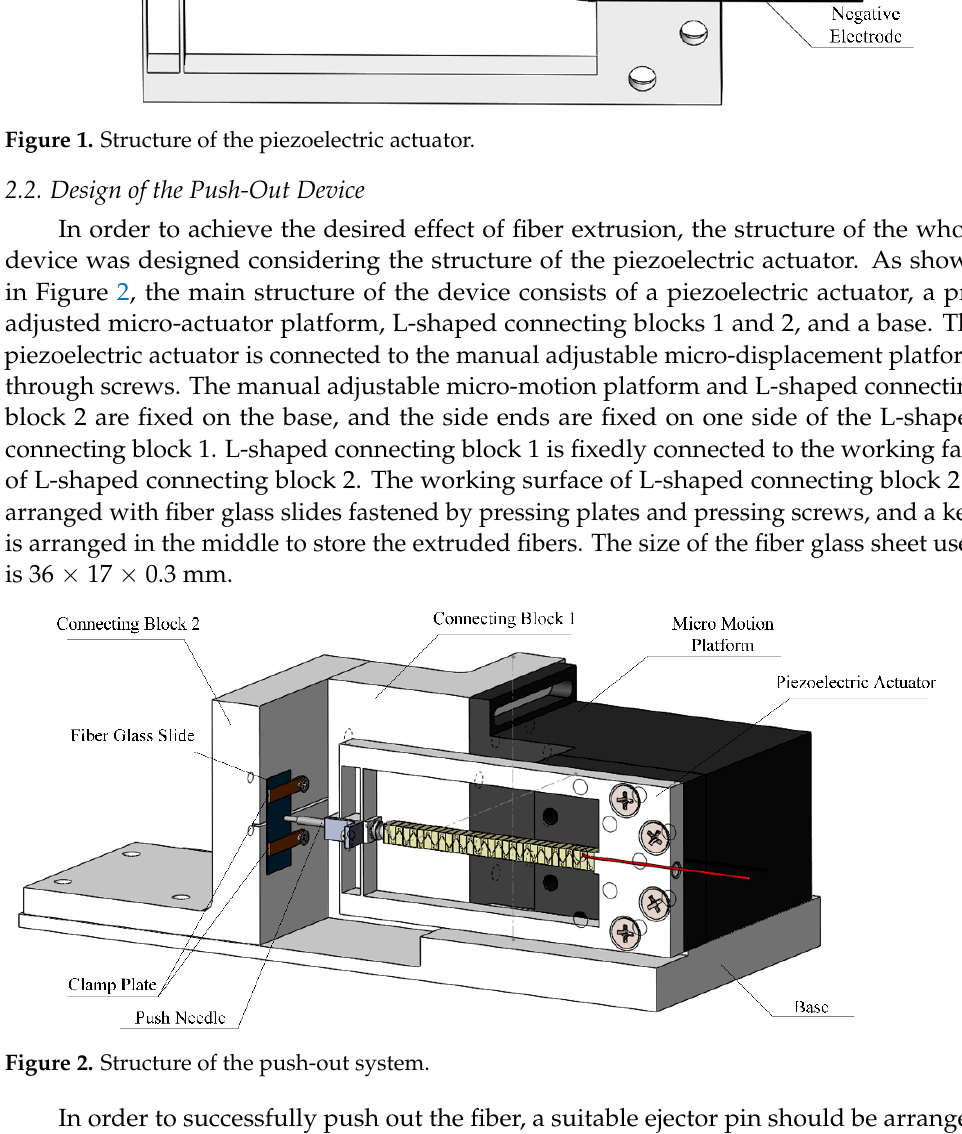
Figure 3. Dimension of the ejector pin. The pre-adjusting micro-motion platform is manually controlled, placed on the base, and the side ends are fixedly connected to the L-shaped connecting block 1. The function of the pre-adjusted micro-platform is to control the ejector pin to approach the fiberglass slowly before the push-out experiment begins. The experiment was carried out under mi- croscopical observation until the ejector pin was aligned with a single fiber. The test system design is shown in Figure 4. The signal generator and power ampli- fier were used to provide the electrical signals required for the normal output of piezoe- lectric ceramics. A laser displacement sensor was used to measure the real-time displace- ment of the extrusion mechanism. A pressure sensor was placed at the lower part of the fiberglass to measure the real-time compressive stress data. A microscope was placed to